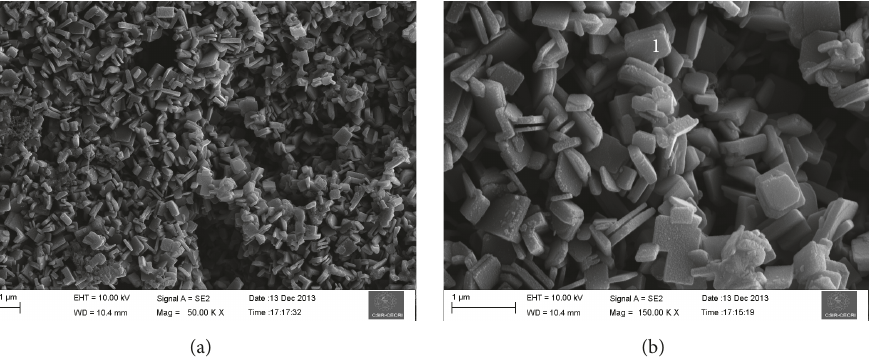
Figure 6: (a) Surface morphology of SrTiO 3 after exposure to hot corrosion in Na 2 SO 4 + 10wt.% NaCl environment at 900 ∘ C and (b) higher magnification image of (a) shows the plate type morphology. EDX analysis was performed on (b) at region 1 (corresponding to Sr 3 Ti 2 O 7